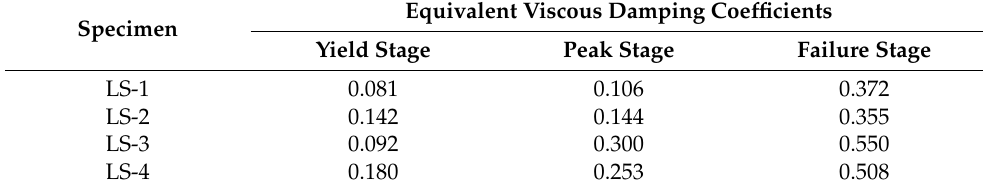
Table 16. Equivalent viscous damping coefficients of LS specimens.